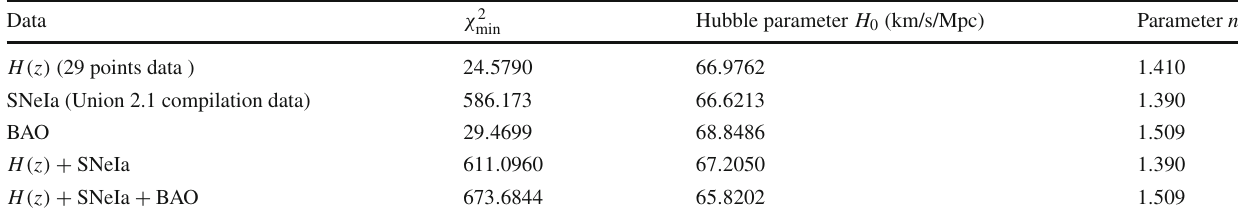
Table 2 Summary of the numerical results for flat Universe Data χ 2